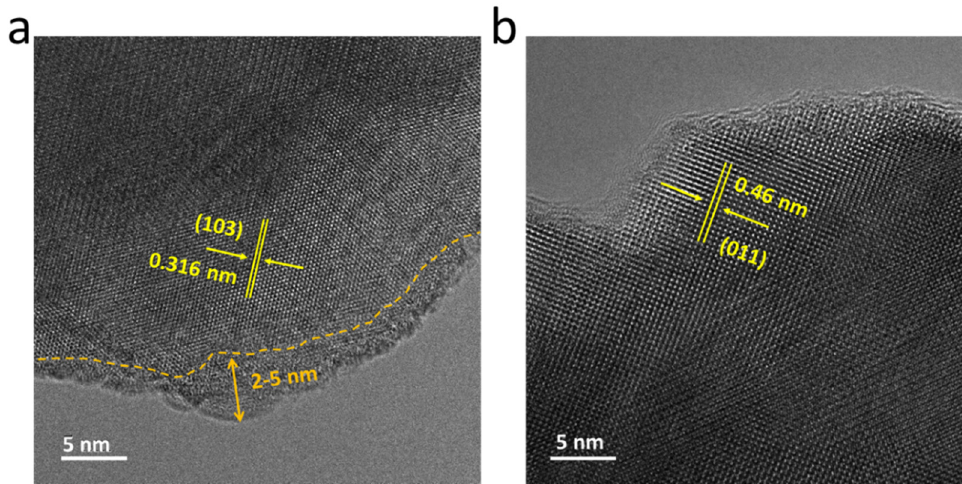
Figure 5. HR-TEM images of ( a ) WB-7cycle and ( b ) WB-5min samples.